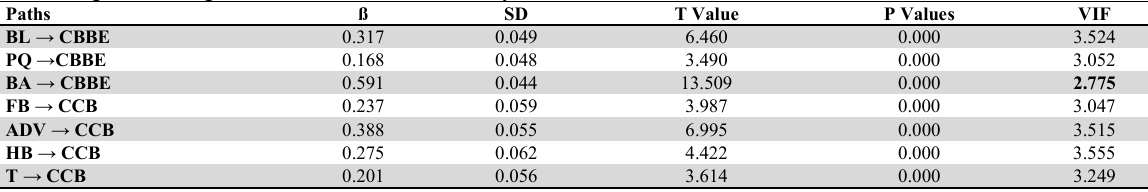
Outer Weights Path Significance and Multi-collinearity